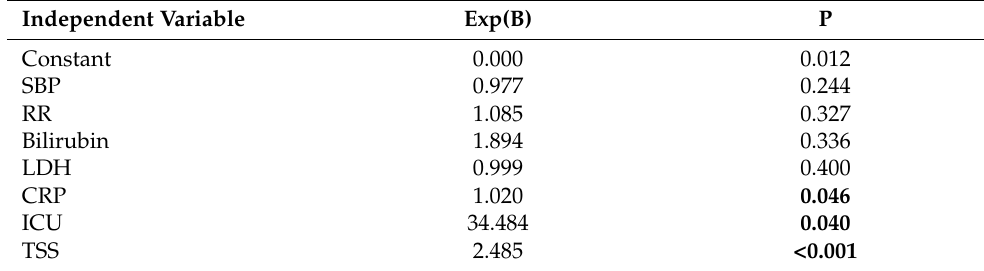
Table 4. Multivariate regression analysis to determine factors associated with